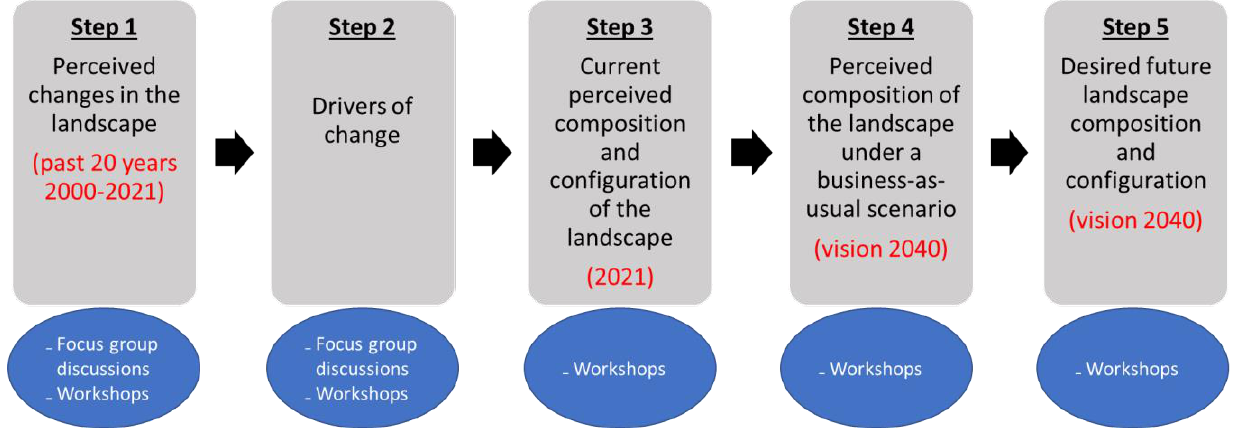
Figure 2. Participatory scenario-building methodology.